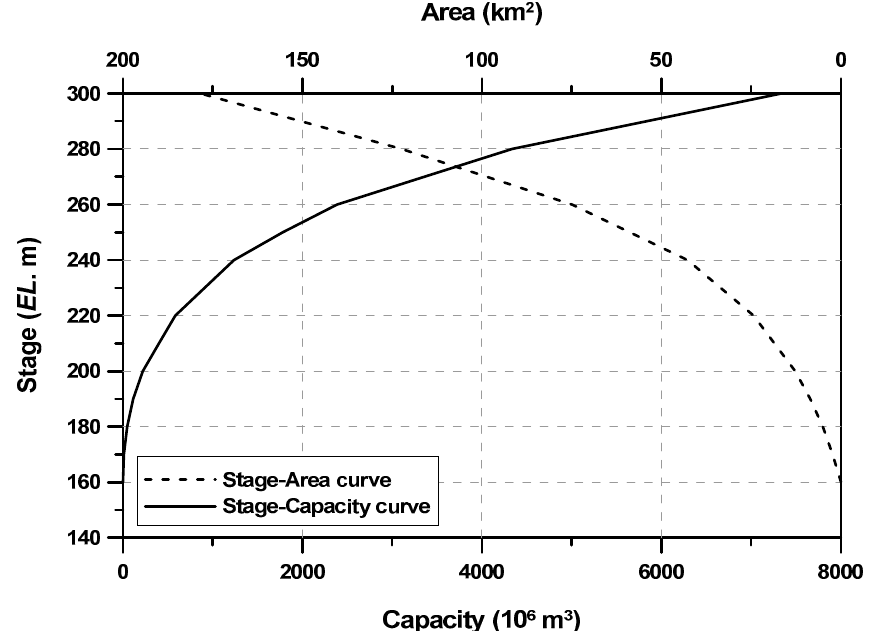
Figure A1. The area-capacity curve of the Peace Dam.